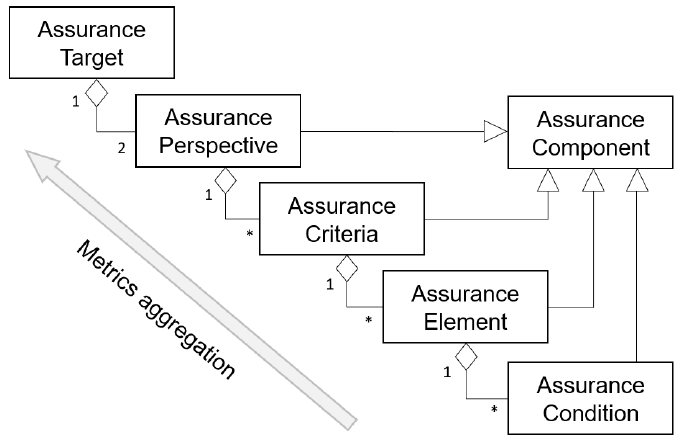
Figure 1. Compositions of the security assurance evaluation model.